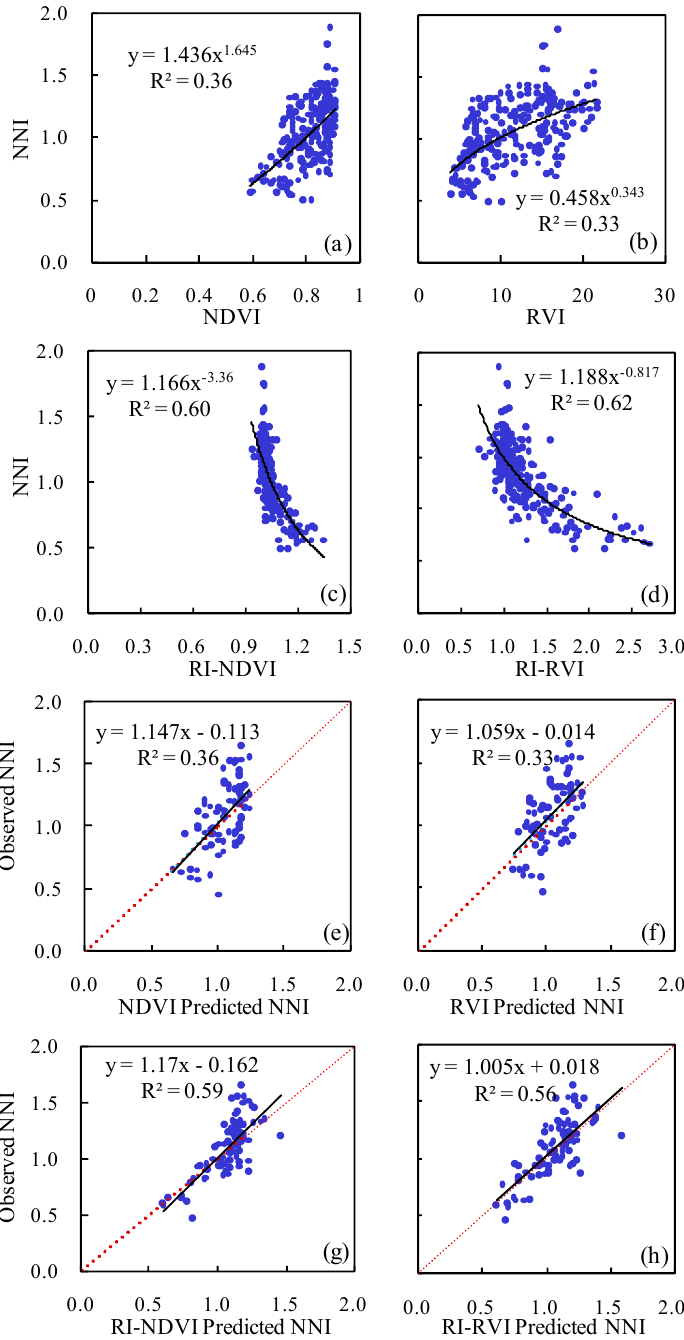
Figure 10. Relationships between N nutrition index (NNI) and GreenSeeker sensor-based normalized difference vegetation index (NDVI) ( a ); ratio vegetation index (RVI) ( b ); response index based on NDVI (RI–NDVI) ( c ) or RVI (RI–RVI) ( d ) across V7 to V10 growth stages, and validation results for the prediction of NNI using NDVI ( e ); RVI ( f ); RI–NDVI ( g ); and RI–RVI ( h ). Black and red lines indicate the regression and the 1:1 lines, respectively.